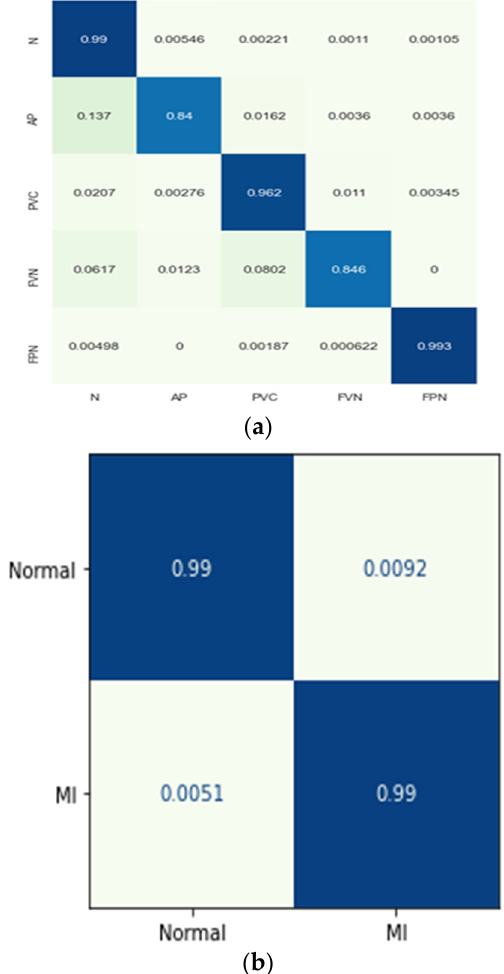
Figure 6. Confusion matrices of the ConvXGB model for ( a ) MIT-BIH and ( b ) PTB.